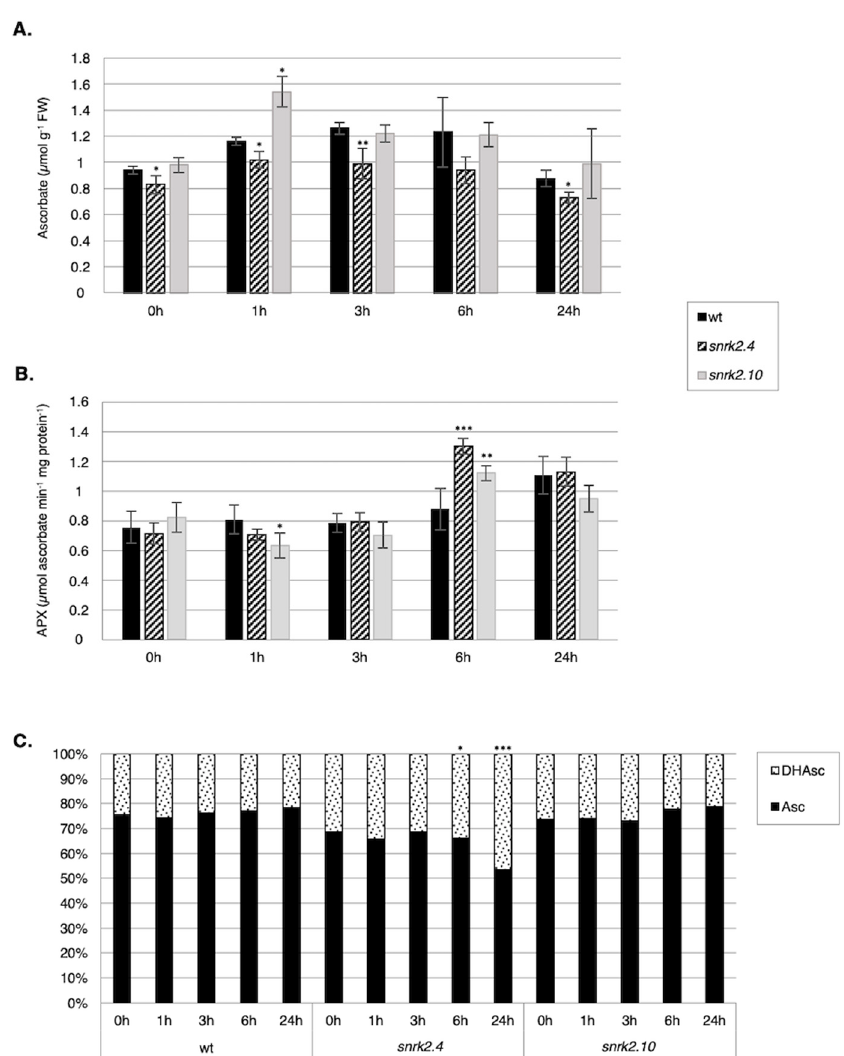
Figure 5. SnRK2.4 and SnRK2.10 regulate ascorbate cycle during response to salt stress. Wild type and snrk2 mutant seedlings were subjected to treatment with 150 mM NaCl for times indicated and ( A ) ascorbate content, ( B ) ascorbate peroxidase (APX) activity, and ( C ) ascorbate redox status were monitored. Asc—ascorbate, DHAsc—dehydroascorbate; error bars represent SD; stars represent statistically significant differences from wt plants (Student t -test for Asc and APX activity, Chi-square test for Asc/DHAsc ratio) where * p < 0.05; ** p < 0.001; *** p < 0.0001. At least two independent biological replicates of the experiment were performed, each with four samples per data point. Results of one representative experiment are shown.